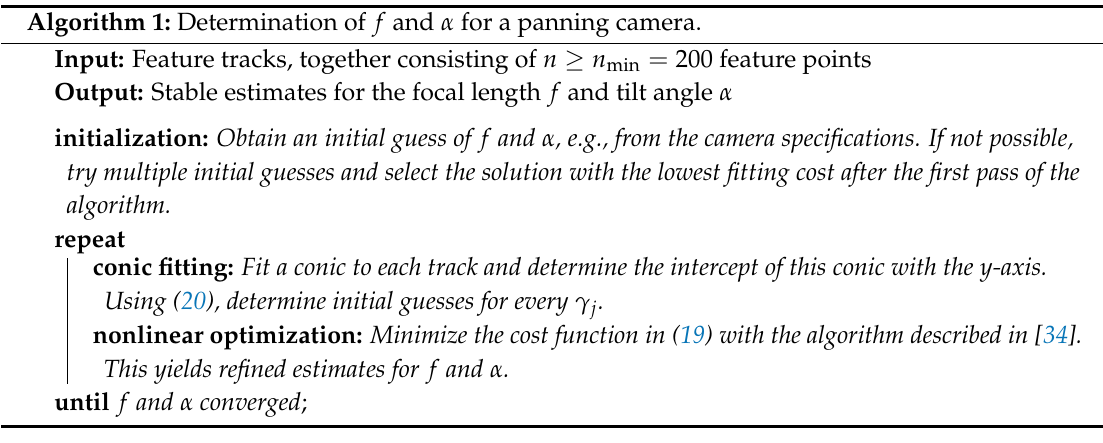
Algorithm 1: Determination of f and α for a panning